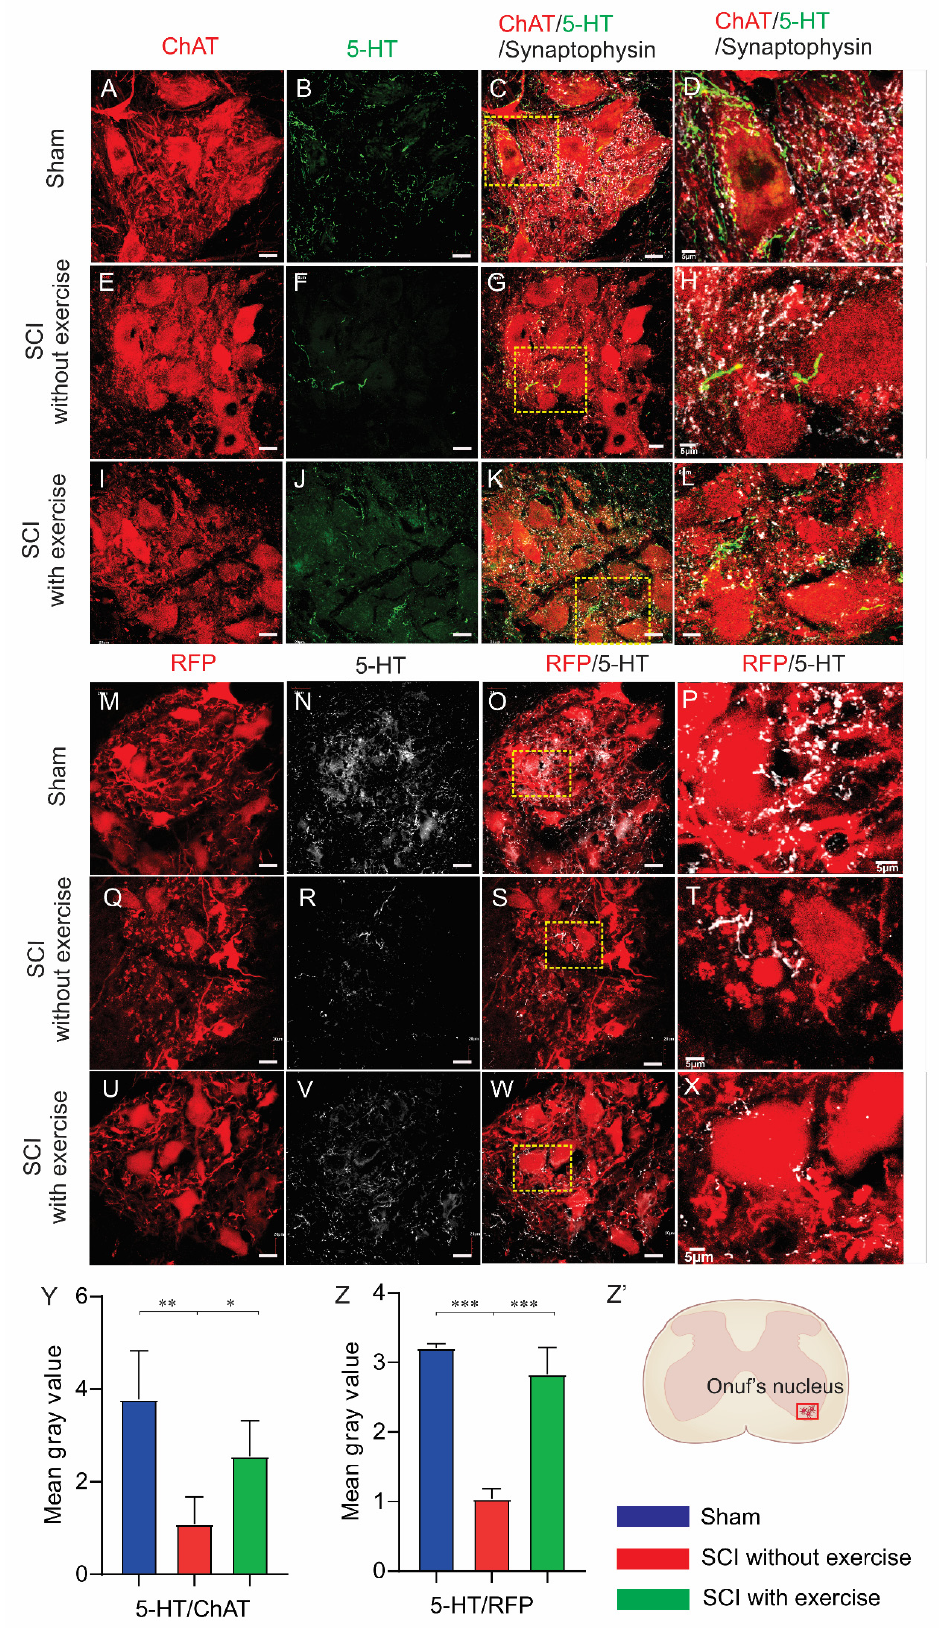
Figure 7. Locomotor exercise increases serotonin innervation of EUS motoneurons. Subgroup of